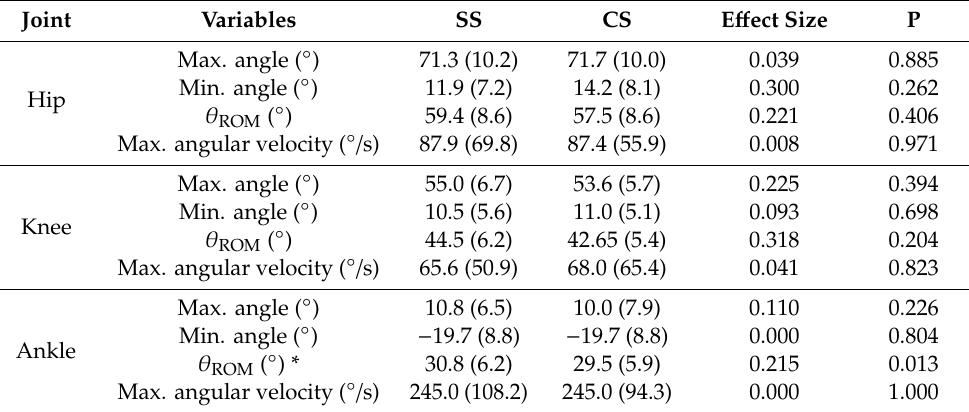
Table 3. Hip, knee, and ankle joint kinematics during LJs (n = 30, Mean